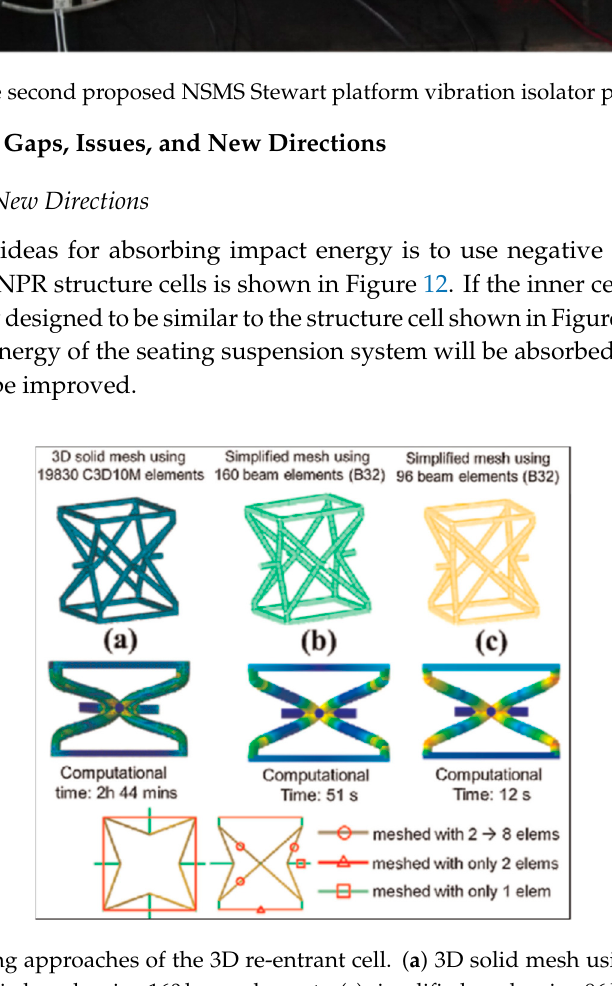
Figure 11. The second proposed NSMS Stewart platform vibration isolator prototype [66].